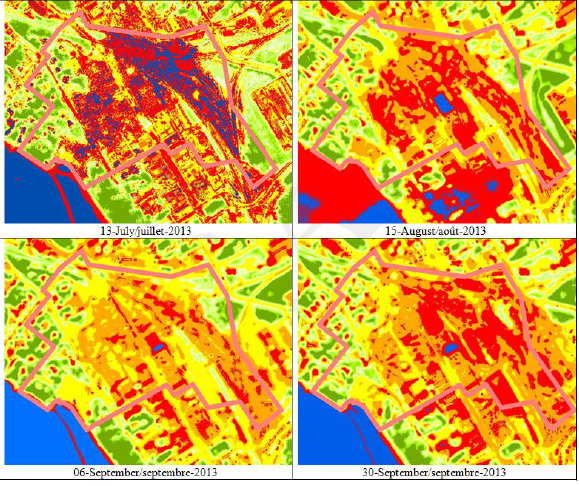
Figure 15. Time progressive NDVI results for the Lac-Mégantic Red Zone. © MDA, All Rights Reserved.